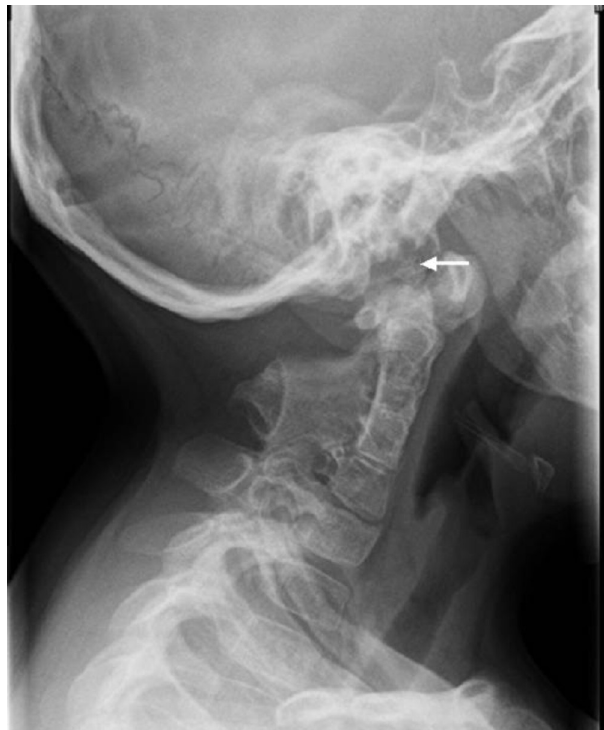
Figure 1 - Lateral radiograph showing atlanto-occipital dissociation (more than 12 mm between the basion and dens with a space clearly visible be- tween the cranium and C1). The radiograph demonstrates extensive fusion throughout the cervical spine of both the anterior and posterior elements. Note the extensive fusion of the vertebral bodies of C2/3-4 and the total fusion of the spinous processes of C2-6. Also, note the detached os terminale